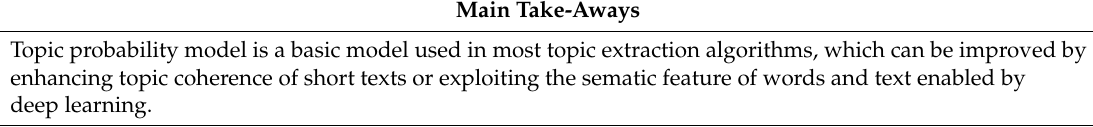
Table 8. Main take-aways for the reader. Main